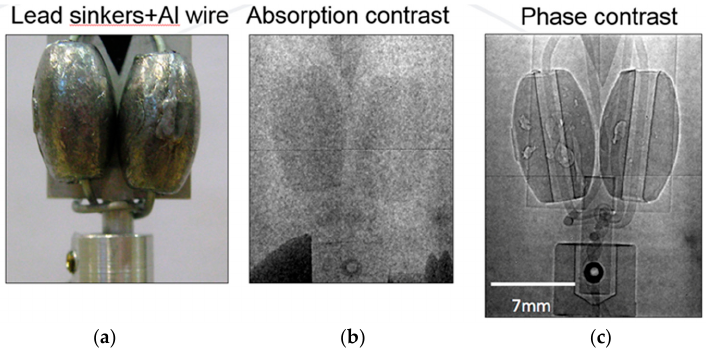
Figure 22. ( a ) photograph of Pb and aluminum wire object ( b ) cold neutron radiograph ( c ) phase contrast image using the propagation technique. The neutron images were taken with a MCP detector.